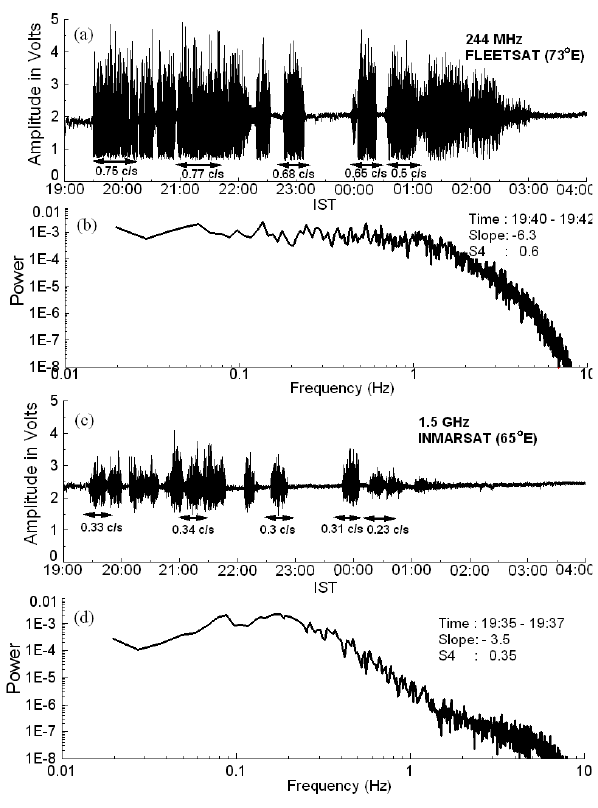
Fig. 1. (a) Typical PBI scintillation record of 244MHz on 26 March 2004. (b) Power spectrum of scintillations of the record shown in Fig. 1a. (c) Typical scintillation record of 1.5GHz on 26 March 2004. (d) Power spectrum of scintillations of the record shown in Fig. 1c.